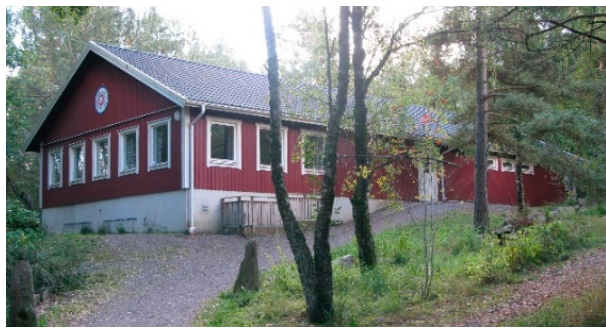
Figure 1. Image of the clubhouse building.